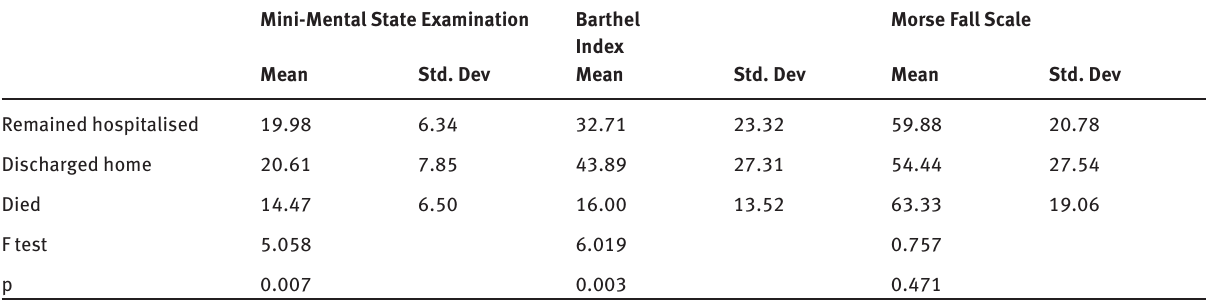
Table 6: Logistic regression by Barthel Index